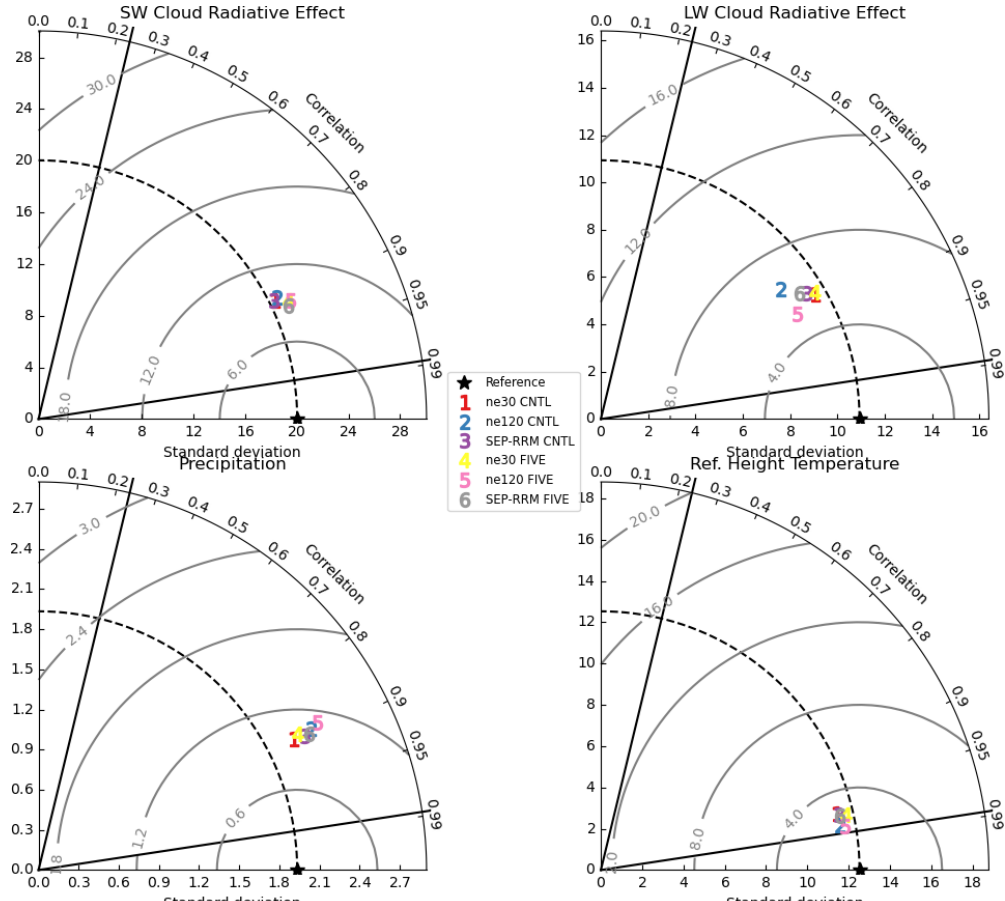
Figure 14. Taylor diagrams depicting the global skill for each simulation for 5 years for shortwave cloud radiative effect (SWCRE), longwave cloud radiative effect (LWCRE), precipitation, and reference height